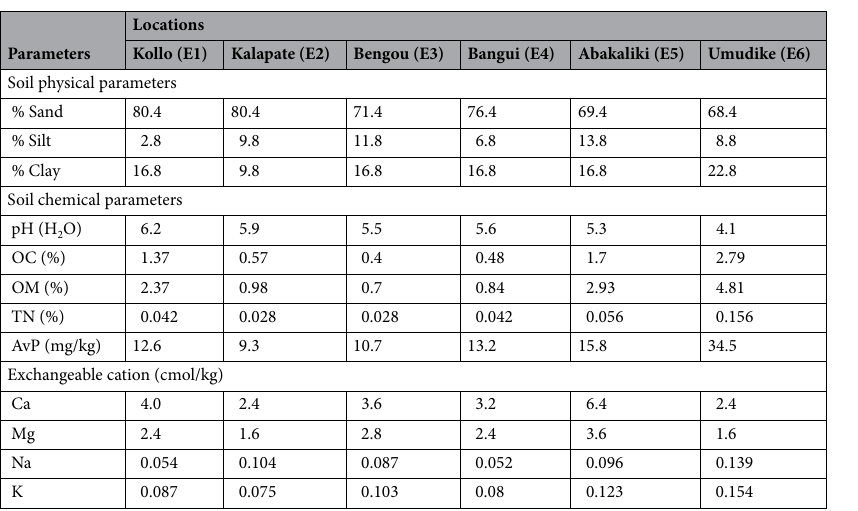
Table 2. Characteristics of soil of the six studied locations in Niger and Nigeria. E environment.